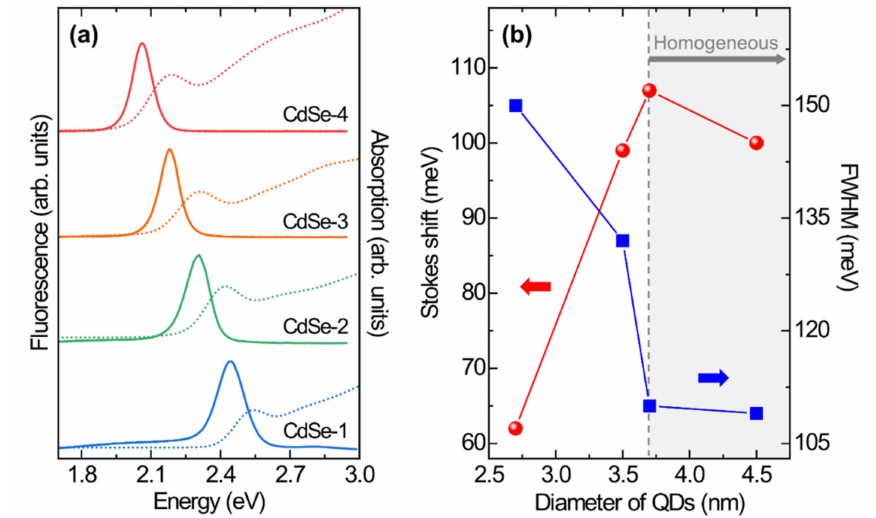
Figure 3. ( a ) The absorption spectra (dashed lines) and fluorescence spectra (solid lines) of CdSe QDs with di ff erent sizes. ( b ) The Stokes shifts and FWHMs of CdSe QDs with di ff erent